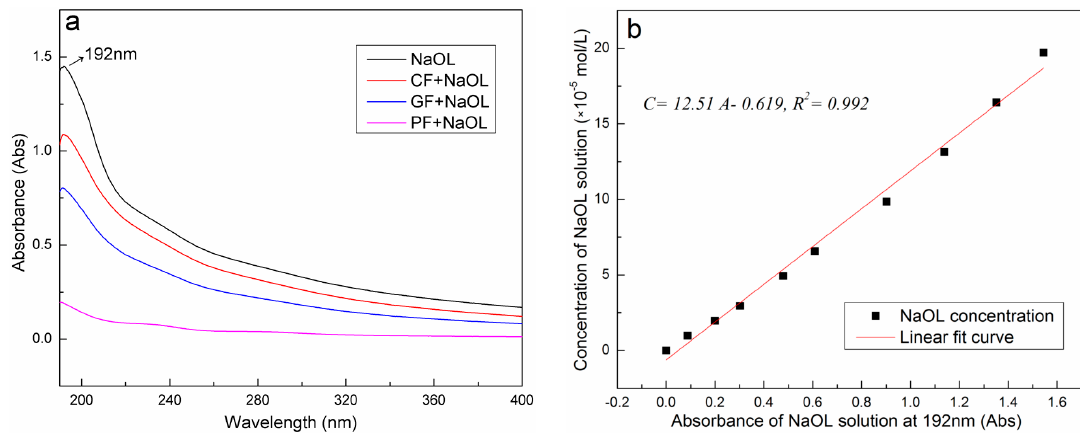
Figure 2. ( a ) UV-Vis absorption spectrum of the NaOL solution before and after adsorption on fluorites; ( b ) the linear fit curve of absorbance and concentration of the NaOL solution.